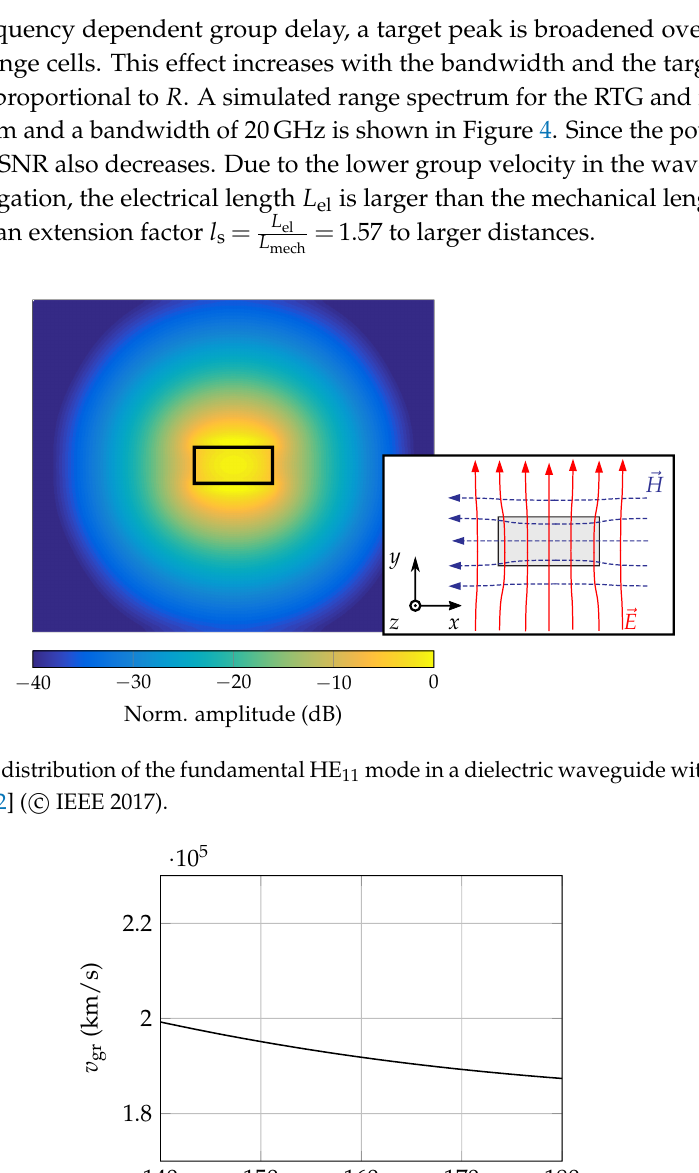
Figure 3. Group velocity v gr over frequency for a rectangular dielectric waveguide with permittivity ε r = 2.25. The cross-sectional area is 1295 µ m